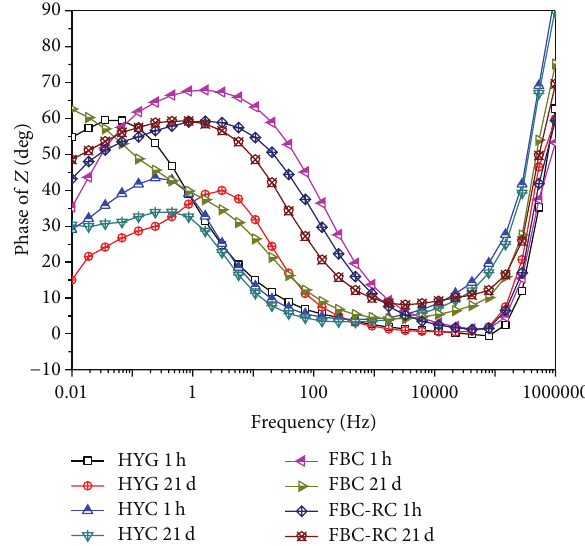
Figure 6: Bode plots of electrodes coated with four kinds of coating in chloride